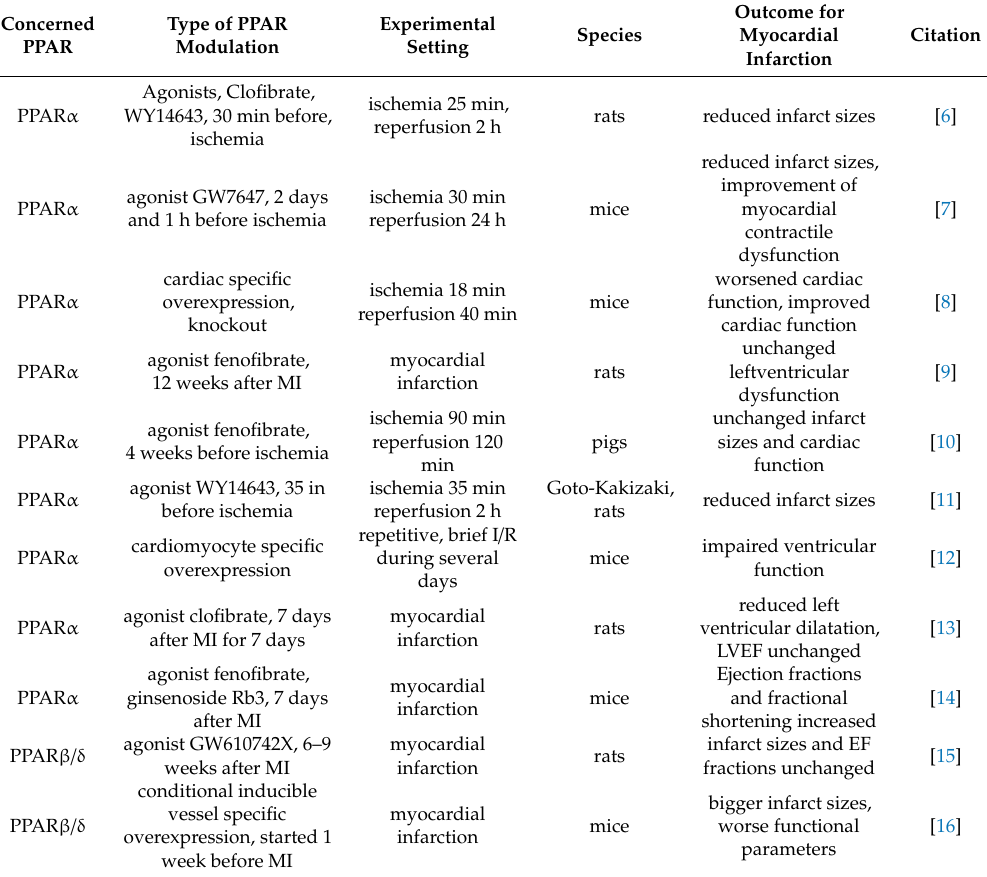
Table 1. Type of peroxisome proliferator-activated receptors (PPAR) modulation and experimental settings used in animal